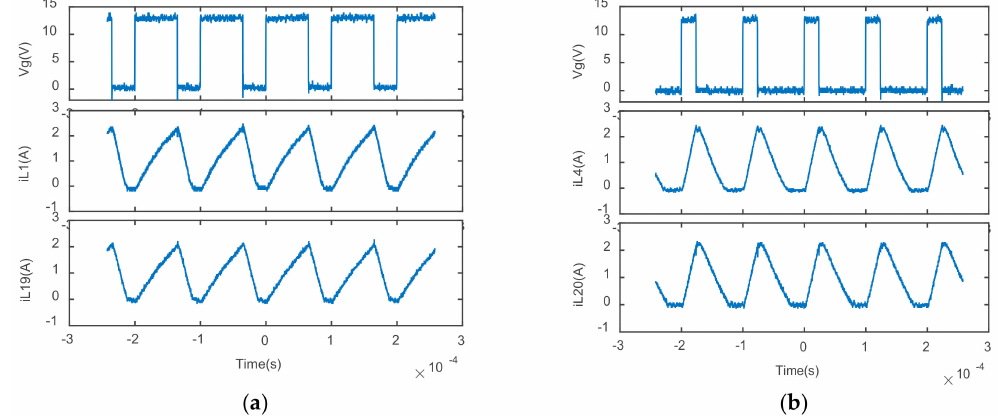
Figure 10. Experimental waveform in the beginning ( a ) i L